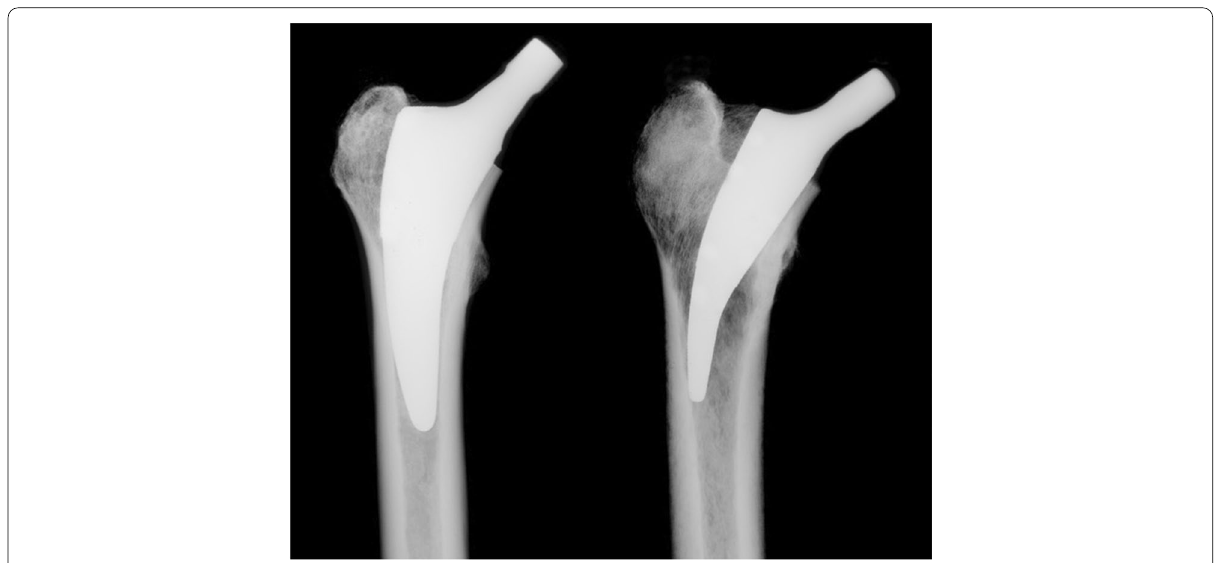
Fig. 2 Radiographs of the Fitmore (left) and the Metha stem